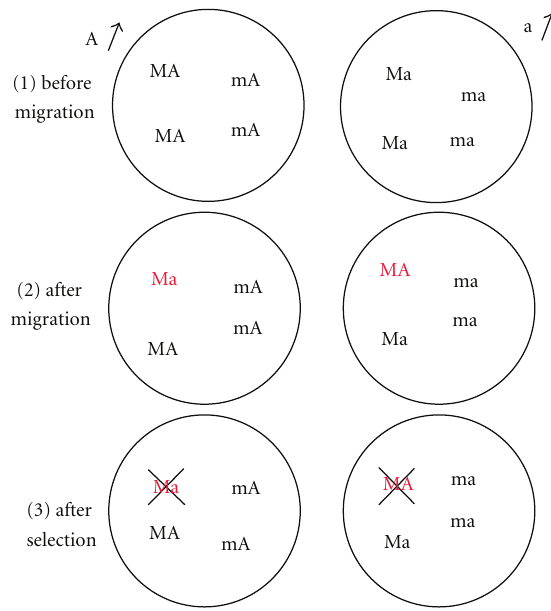
Figure 2: Indirect selection on a migration modifier with local adaptation. Sketches how a migration modifier evolves in presence of local adaptation (for the sake of illustration the M allele causes maximal migration (1/2) and the m allele zero migration). Before migration (step 1) consider two habitats with haploid individuals. Before migration (step 1) consider two habitats with haploid individuals. On the left the A allele is favored at a local adaptation locus whereas a is favored on the right. To make things simple we consider these alleles to be fixed where they are beneficial. During migration only individuals with allele M move between habitats (step (2) migrants in red). Half of the M individuals move to the other habitat and the other half stays at home. Importantly migration directly generates LD between the M allele and the locally inferior allele (the locally inferior allele is found only with M and not with m). Finally, selection occurs favoring A on the left and a on the right very strongly in the illustration and carries the m allele with the adaptation locus because of the linkage disequilibrium generated at the previous step (the m overall frequency has raised from 1/2 to 2/3 on the illustration). Note that in a finite population kin selection by contrast favors M